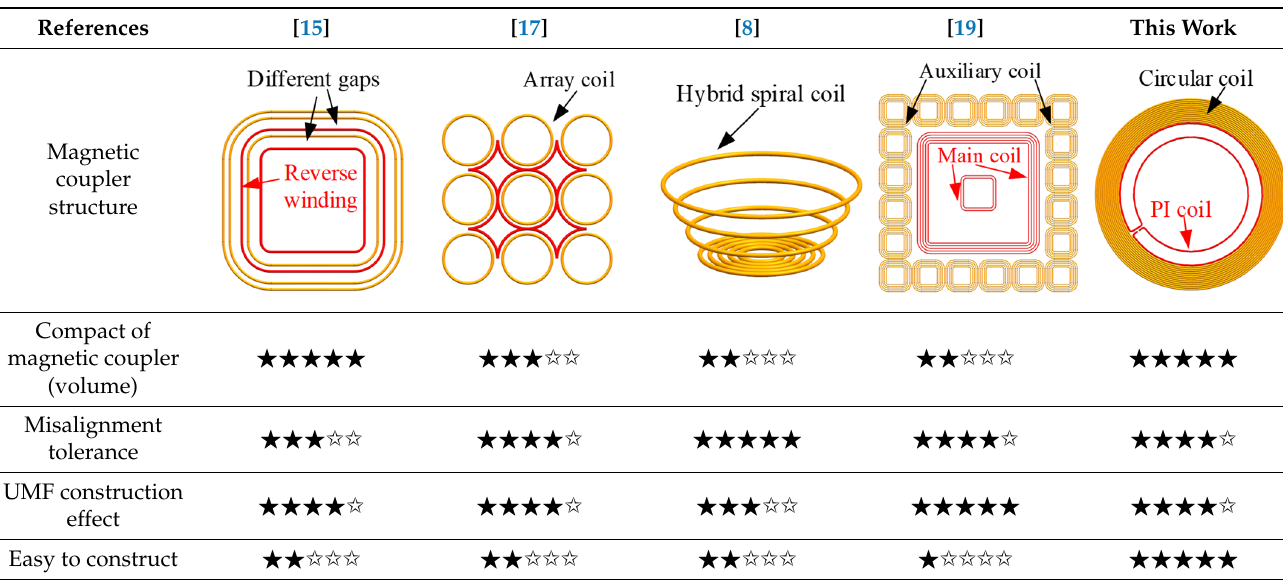
Table 1. Comparison of some UMF construction methods.